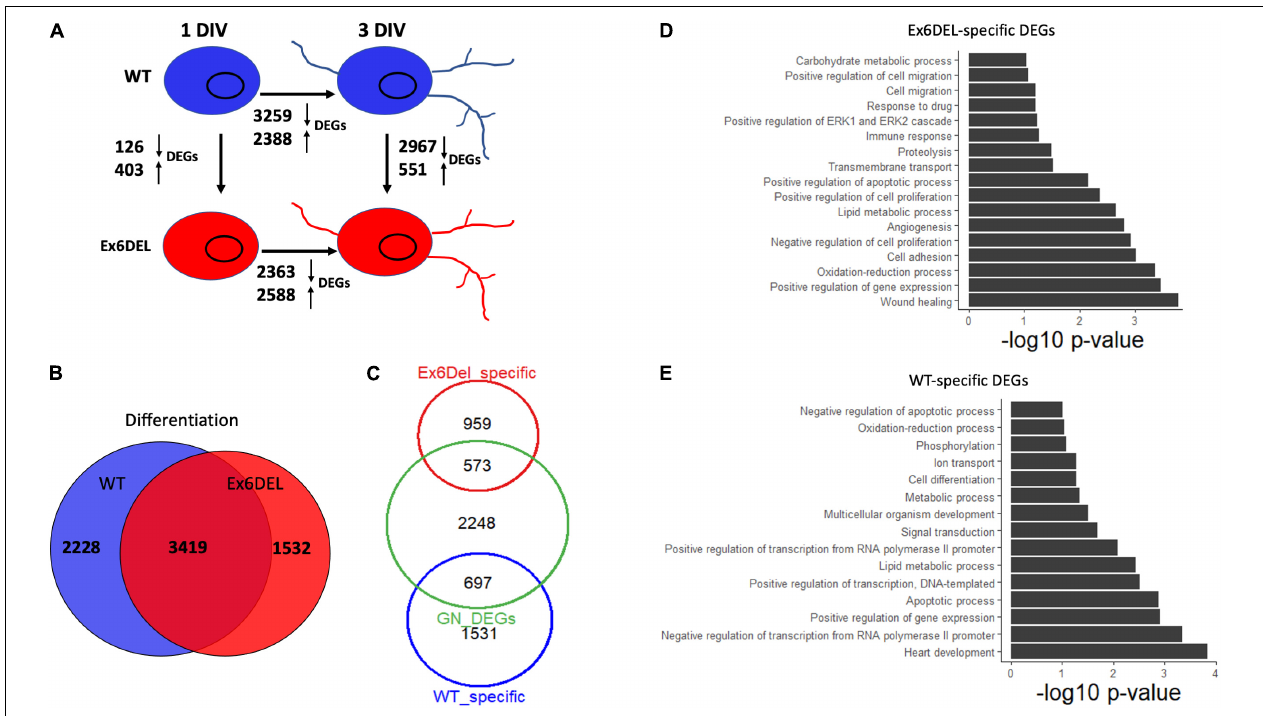
FIGURE 6 | Ex6DEL cultures are delayed in differentiation. (A) Schematic diagram showing the numbers of differentially expressed genes (DEGs) between different samples (WT and Ex6DEL) and days in culture (same as Figure 3A ). (B) Venn diagram showing overlapping differentially expressed genes in WT or Ex6DEL cultures during differentiation (gene expression comparison between I and 3 DIV). (C) Venn diagram highlighting that only 1/3 of the uniquely expressed genes from (B) (Ex6DEL specific: 1532; WT-specific: 2228) remain differentially expressed at 3 DIV. Green circle comprises the 2967 down- and 551 up-regulated DEGs between WT and Ex6DEL cultures. (D,E) GO term analysis of the DEGs at # DIV that were specific to the Ex6DEL (D) or WT (E)